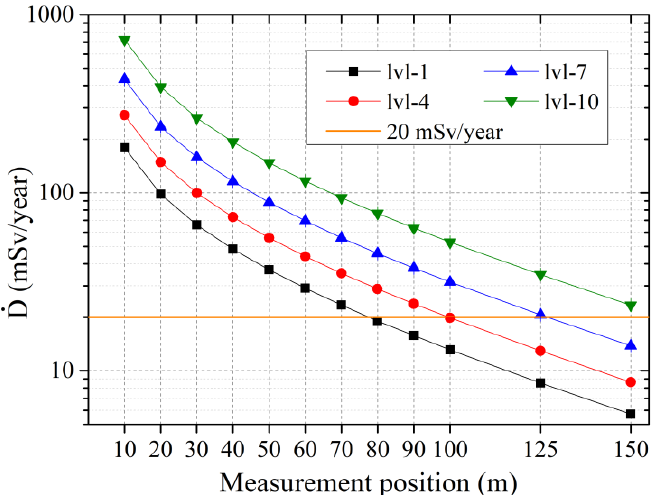
Figure. 5. The annual γ - dose rate values in dependence on 12 MPs for 4 different repository configurations (lvl-1, lvl-4, lvl-7 and lvl-10). For the comparison, limiting dose value for a professional worker is shown (20 mSv/year - full